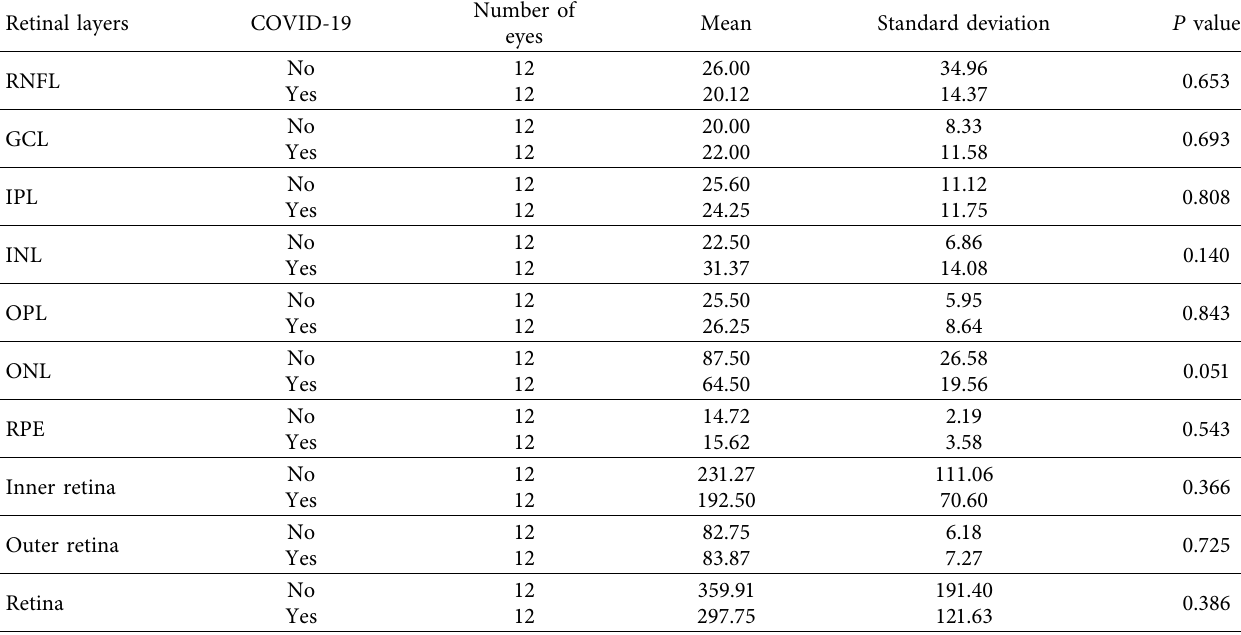
Table 4: Comparison of diferent retinal layers thickness of EE patients with and without COVID-19. Retinal